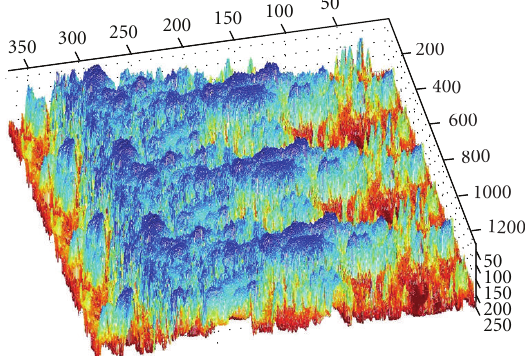
Figure 10: The constructed turbulence kinetic energy distribution surface of NURBS in high-pressure reversing valve